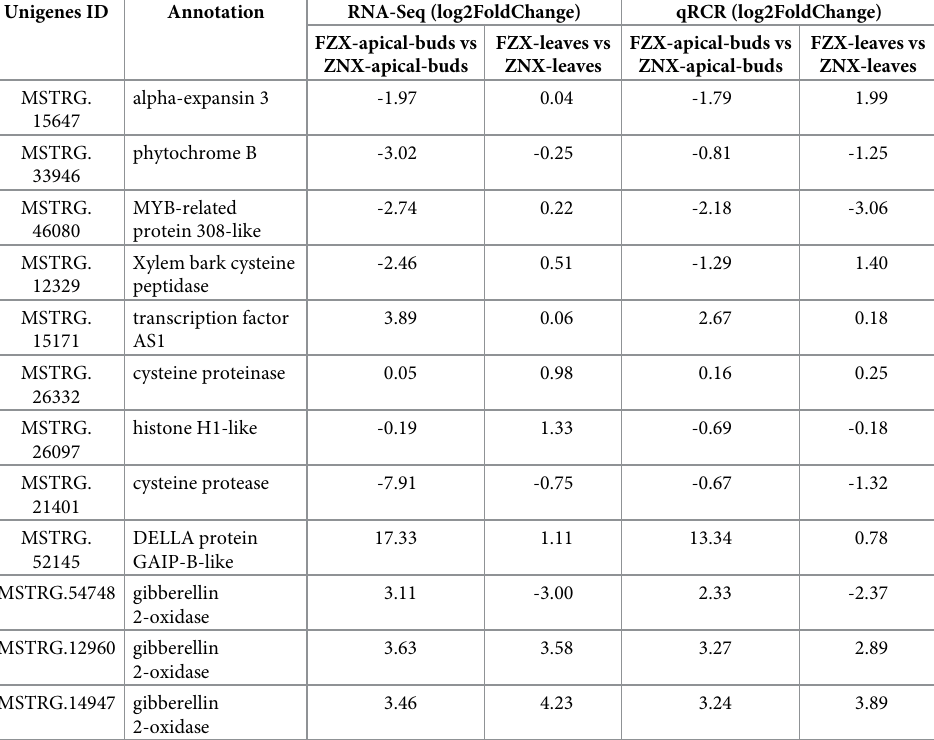
Table 3. Confirmation of RNA-Seq expression profiles with qRT-PCR. Lcactin was used as reference gene to nor- malize gene expression levels under identical